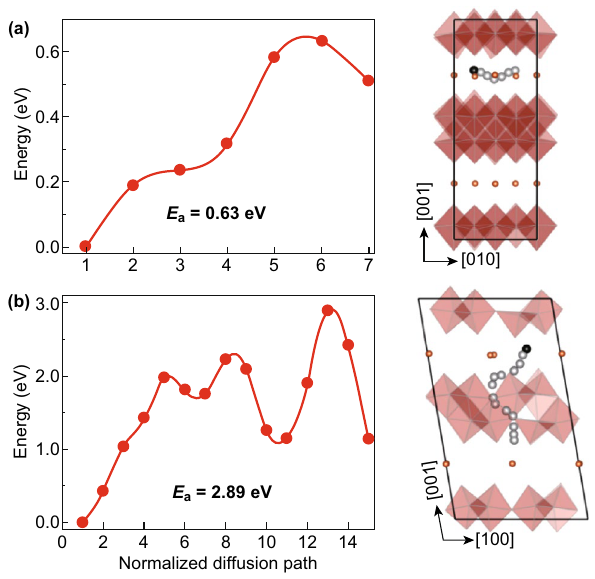
Fig. 1 Calculated minimum energy paths of Zn 2+ ion diffusion along a [010] and b [001] in monoclinic NH 4 V 4 O 10 . Orange and black balls represent NH 4+ ions and the most energetically favorable pathway for Zn 2+ ion intercalation, respectively. The VO layers are indicated by red polyhedrons. (Color figure